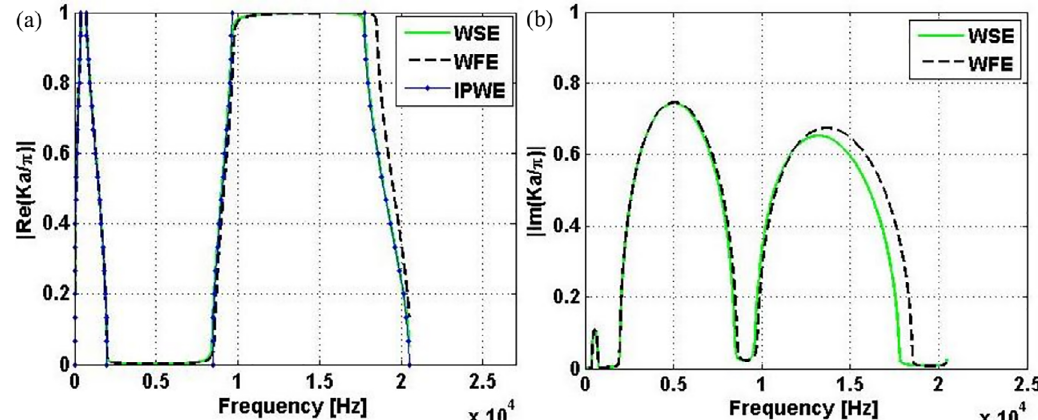
Figure 12. Complex elastic band structure of the real PC beam. The real part of the reduced Bloch wave vector (dimensionless) (a) calculated by WSE, WFE and IPWE methods and the imaginary part of reduced Bloch wave vector calculated by WSE and WFE